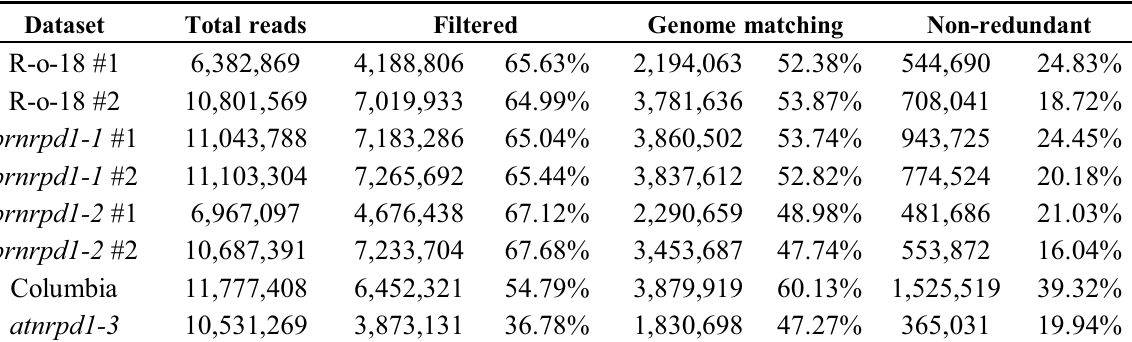
Table 1. Small RNA-seq